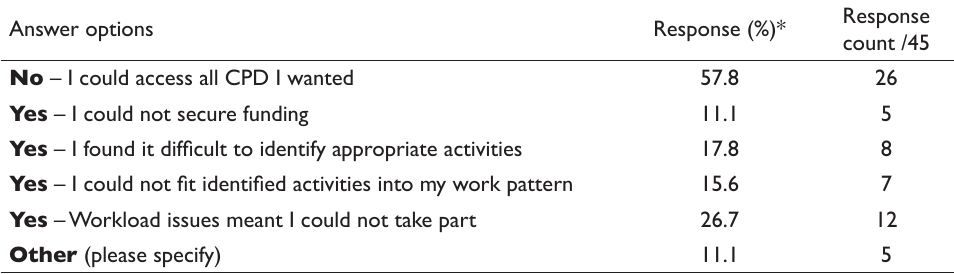
Table 2: Were there any problems in accessing CPD? Answer